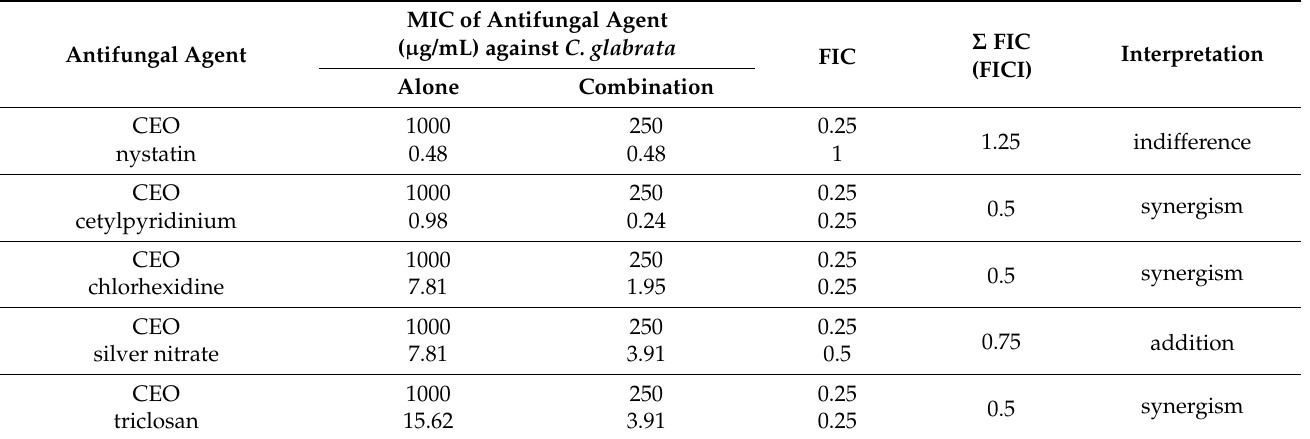
Table 6. MICs and FIC indices of CEO alone and in combination with selected antimycotics on reference C . glabrata ATCC 90030